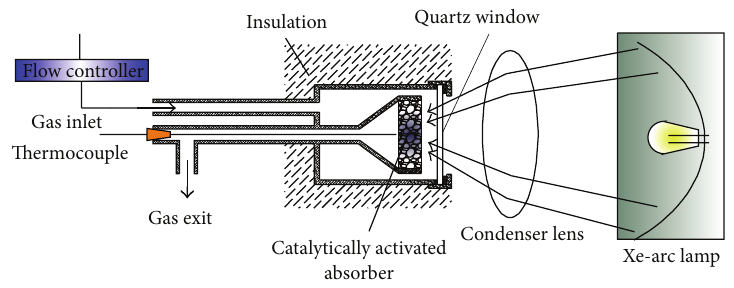
Figure 1: Schematic of the main part in